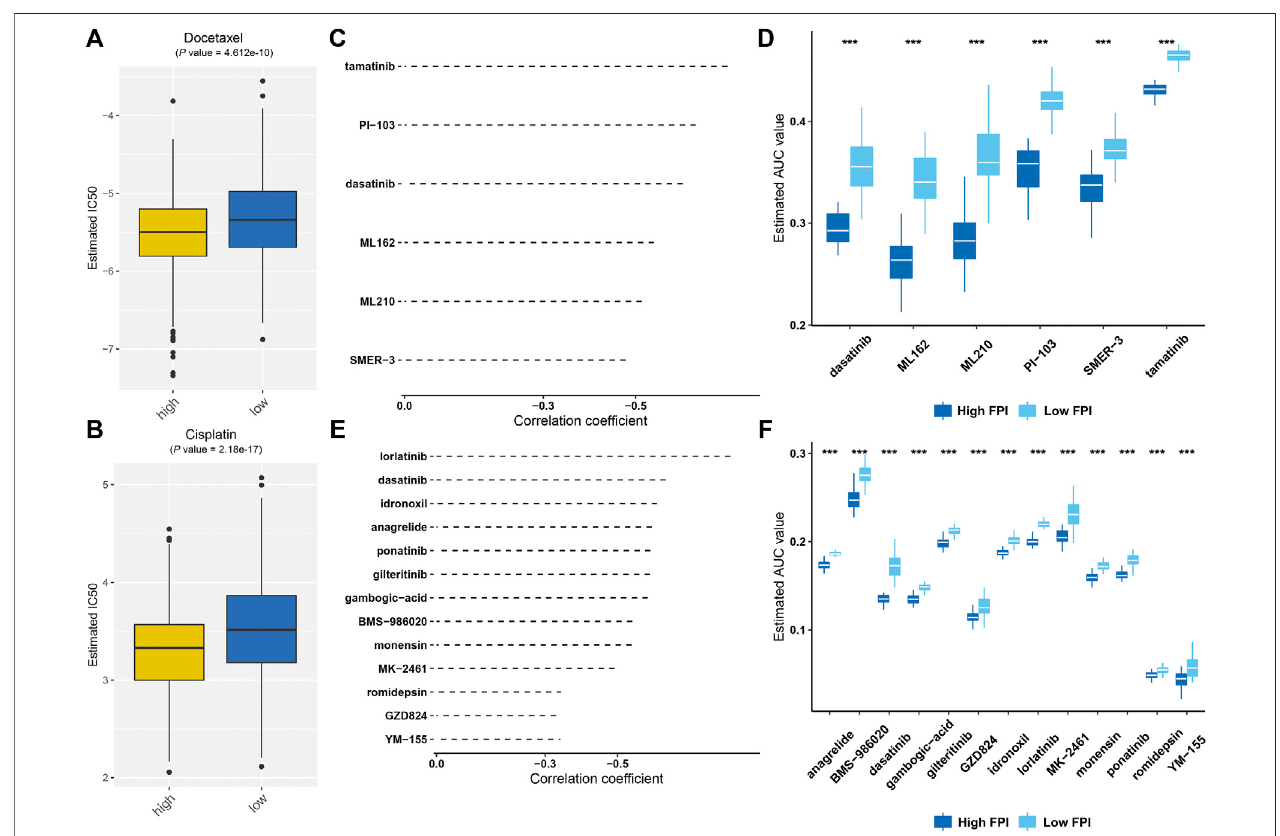
FIGURE8| PredictionofpotentialtherapeuticagentsagainstGCbasedonFPIscore. (A,B) ComparisonofestimatedIC50valuesofdocetaxelandcisplatininhigh and low FPI score patients. (C) Spearmancorrelation analysis between FPI score and six CTRP-derived compounds. (D) Comparison ofthe estimated AUC value ofsix CTRP-derived compounds in high and low FPI score patients. (E) Spearman correlation analysis between FPI score and thirteen PRISM-derived compounds. (F) Comparison of estimated AUC value of thirteen PRISM-derived compounds in high and low FPI score patients. *** p < 0.001.